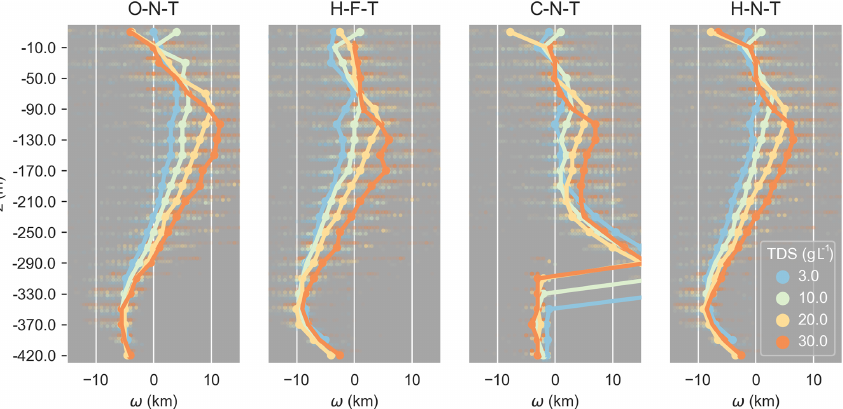
Figure 9. Isosurface separation ω with depth for different TDS values and selected model scenarios. The line indicates the median isosurface separation, the near-transparent dots all data points. Positive ω means the isohaline of the palaeohydrogeological reconstruction is located more land-inward than its steady-state equivalent and vice